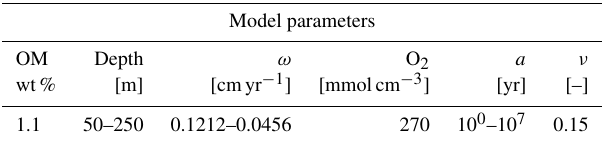
Table 3. Model boundary conditions representative of shallow shelf marine sediments for the SMTZ simulations. Calculation for ω are from Burwicz et al.